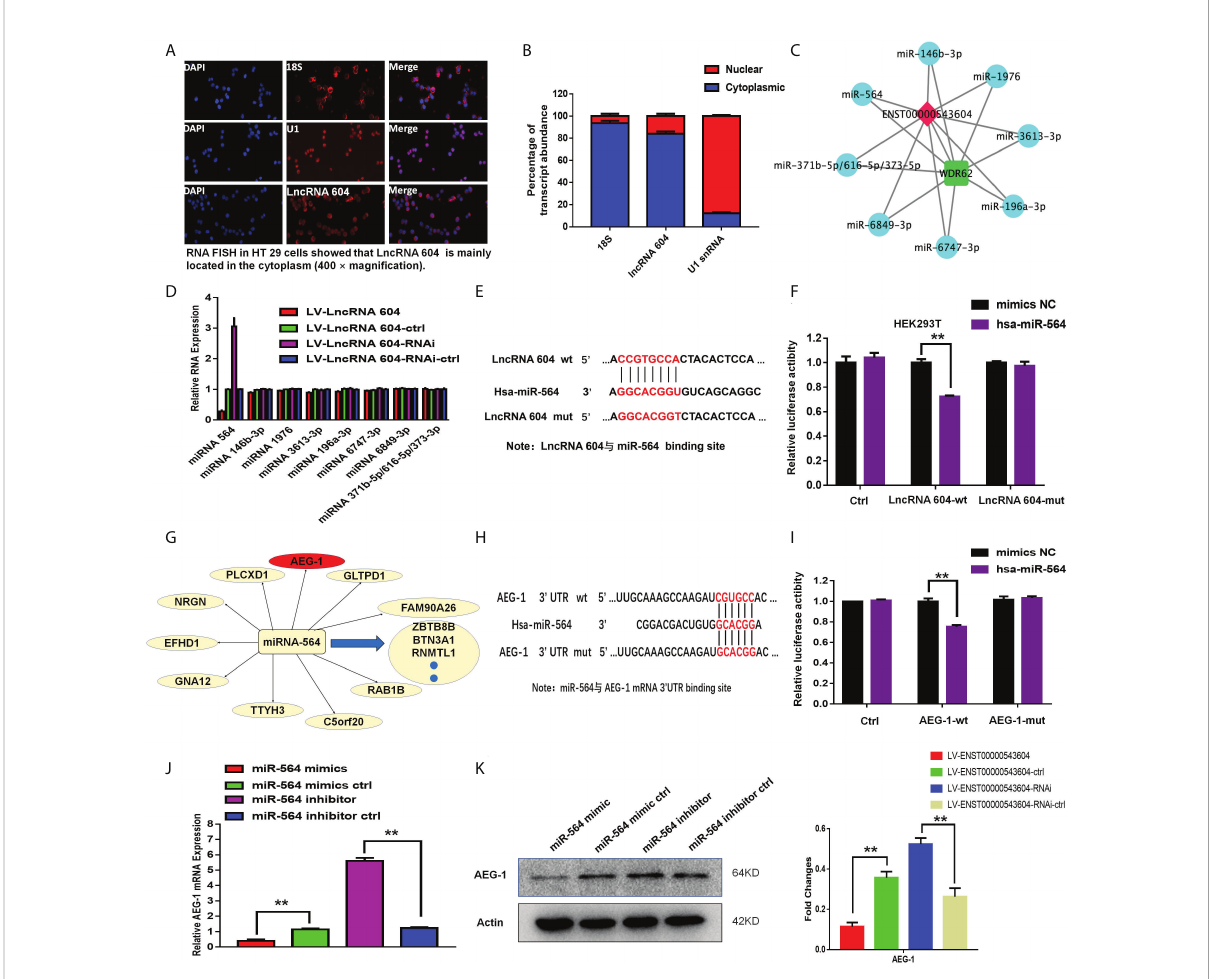
FIGURE 3 The mechanism of lncRNA 604 was detected as ceRNA. (A) The localization of lncRNA 604 was detected by FISH assay in the cells. (B) The expression of lncRNA 604 compared with the nuclear localization U1 and the cytoplasmic localization marker 18S. (C) LncRNA 604 spatial signal regulation network was generated by Targetscan software. (D) MiRNA 564 was regulated by lncRNA 604 by qRT-PCR in these bound miRNAs. (E) The binding site of lncRNA 604 and miRNA 564. (F) MiRNA 564 bounded the wild type of lncRNA 604 by the dual luciferin reporter gene. (G) The putative target genes of miRNA 564 was predicted by MiRanda (http://www.microrna.org). (H) The binding site of miRNA 564 and AEG- 1. (I) miRNA 564 mimics reduced the luciferase activity of wt 3 ’ UTR of AEG-1, while had no effect on mut 3 ’ TUR of AEG-1. (J, K) MiRNA 564 could negatively regulate AEG-1 by qRT-PCR and WB [ (J) RNA; (K) protein]. All ** P <